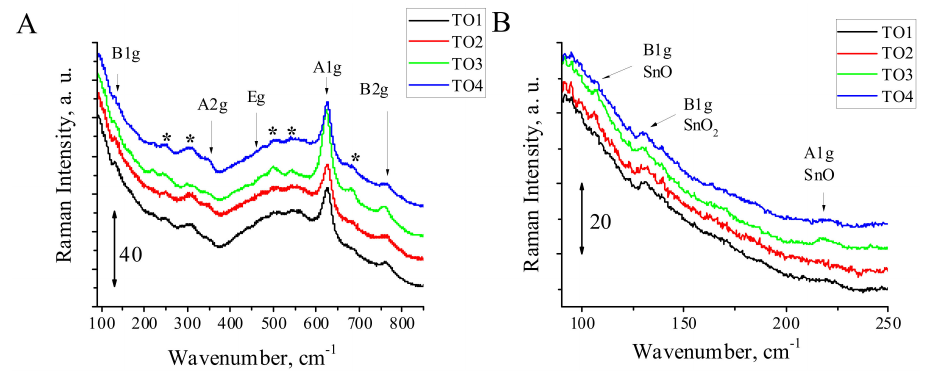
Figure 6. Raman spectra of samples ( A ) and magnified region for range 100–250 cm − 1 ( B ). Volume (specified by arrows) and surface (specified by asterisks) modes correspond to SnO 2 . Vibration modes of SnO are depicted in ( B